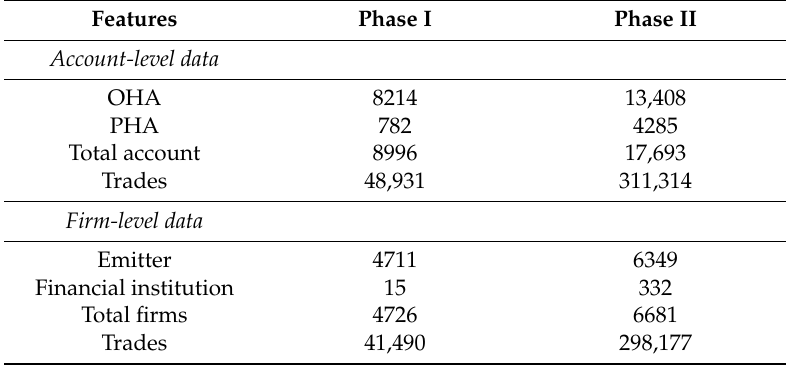
Table 1. Features of the EUTL